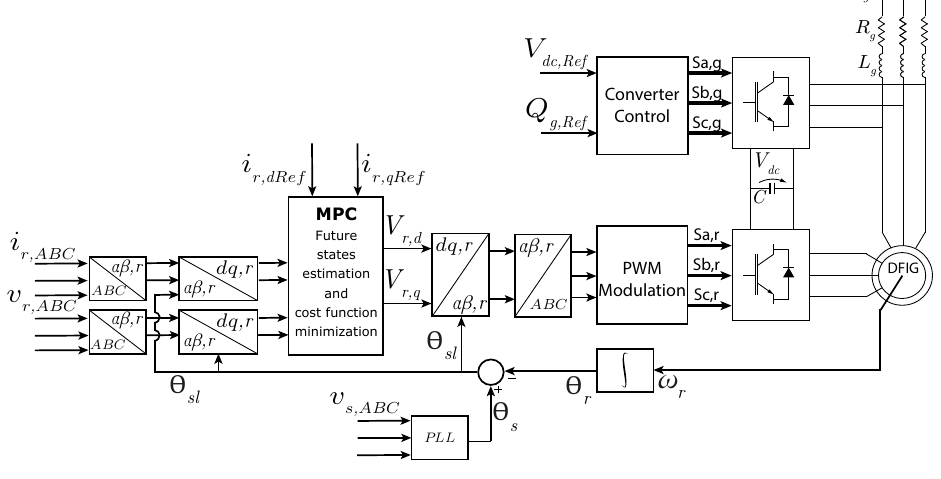
Figure 12. Diagram of MPC for